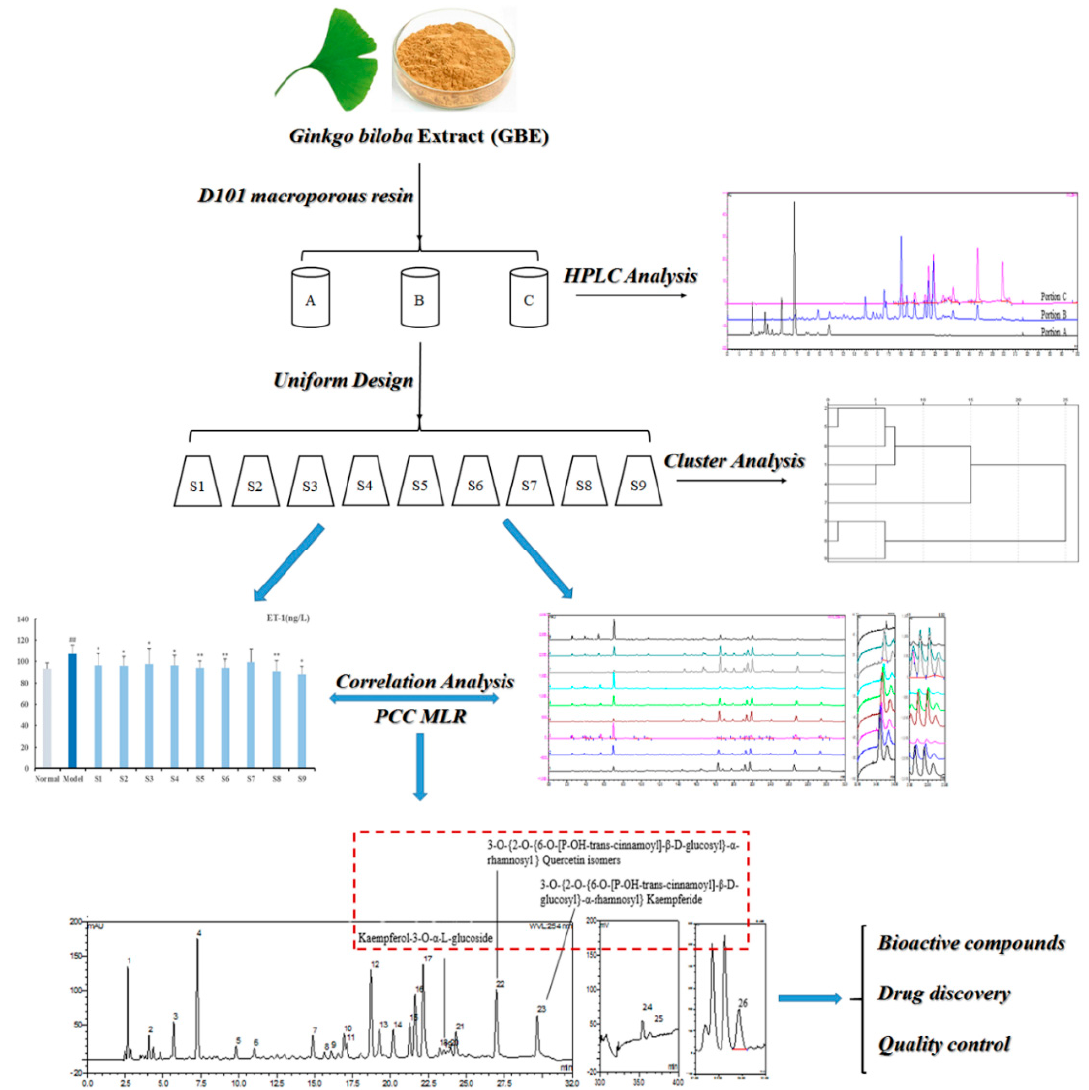
Figure 1. Research process for discovery of bioactive compounds affecting endothelial function in GBE.